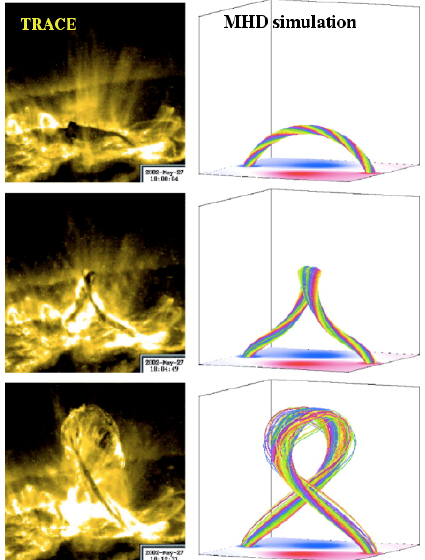
Fig. 8. Left panels: observations of a filament eruption close to the limb. Right panels: Magnetohydrodynamics simulation of the kink instability in a bipolar magnetic configuration. The simulation was rotated so that the photospheric magnetic inversion line corresponds to the initial direction of the observed filament. The simulated flux rope length was also scaled to the filament extension. The time evo- lution of the kinked flux rope is closely comparable to the observed filament writhing. Here the eruption is confined (thus better visi- ble because it is denser). Similar results are also obtained in some eruptive cases (T¨or¨ok and Kliem,